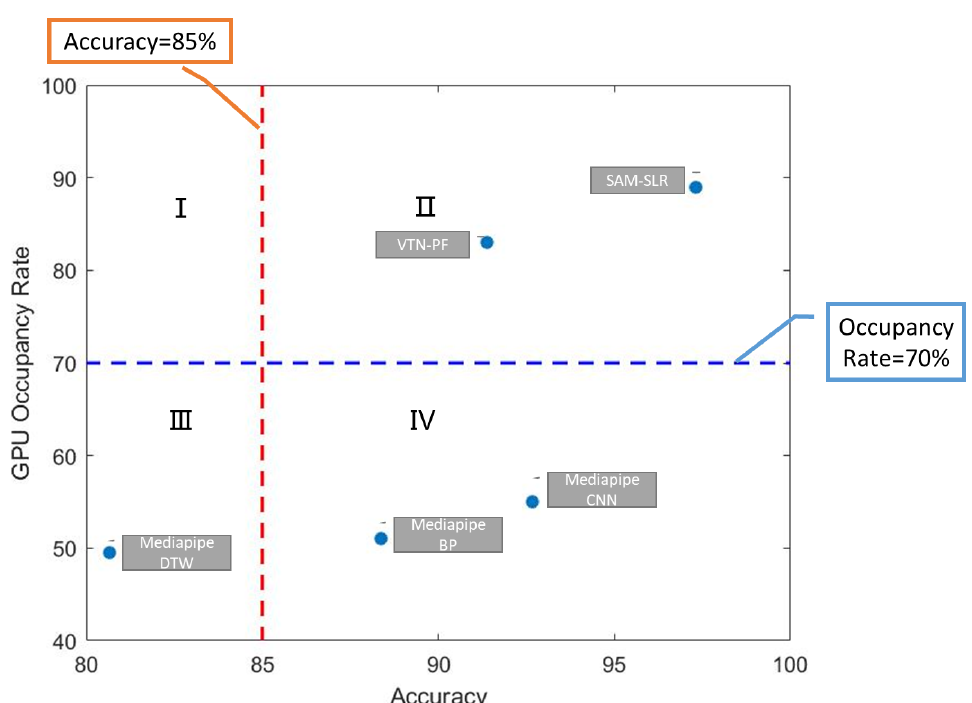
Figure 3. AUTSL large-scale dataset test results on Android mobile devices. Each point in the figure represents a recognition method. Coordinate values are